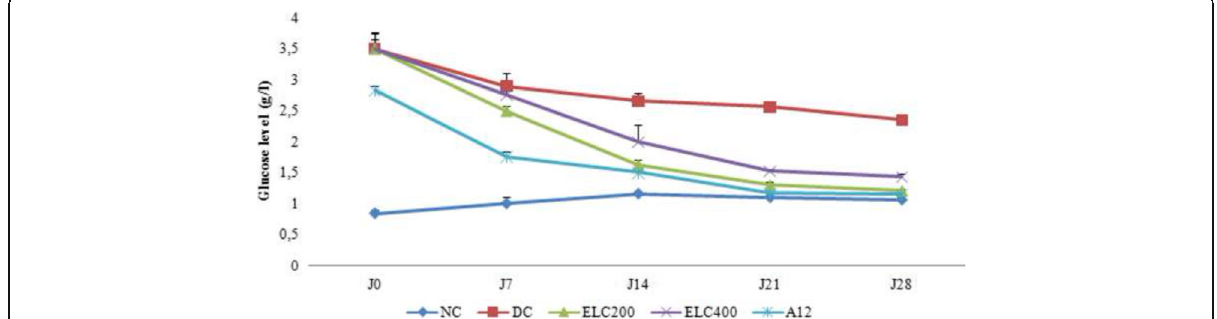
Fig. 4 Blood glucose levels in experimental groups of rats. Normal (NC) and Diabetic control (DC). ELC200&400: Ethanol extract from leaves of C. scolymus at doses of 200 and 400 mg/kg per day; A12: Acarbose at dose of 12 mg/kg per day for 28 days. The values are means ±SD ( n = 8 for each